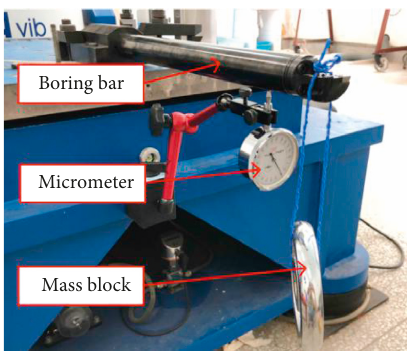
Figure 3: Photograph of a stiffness test of the boring bar.